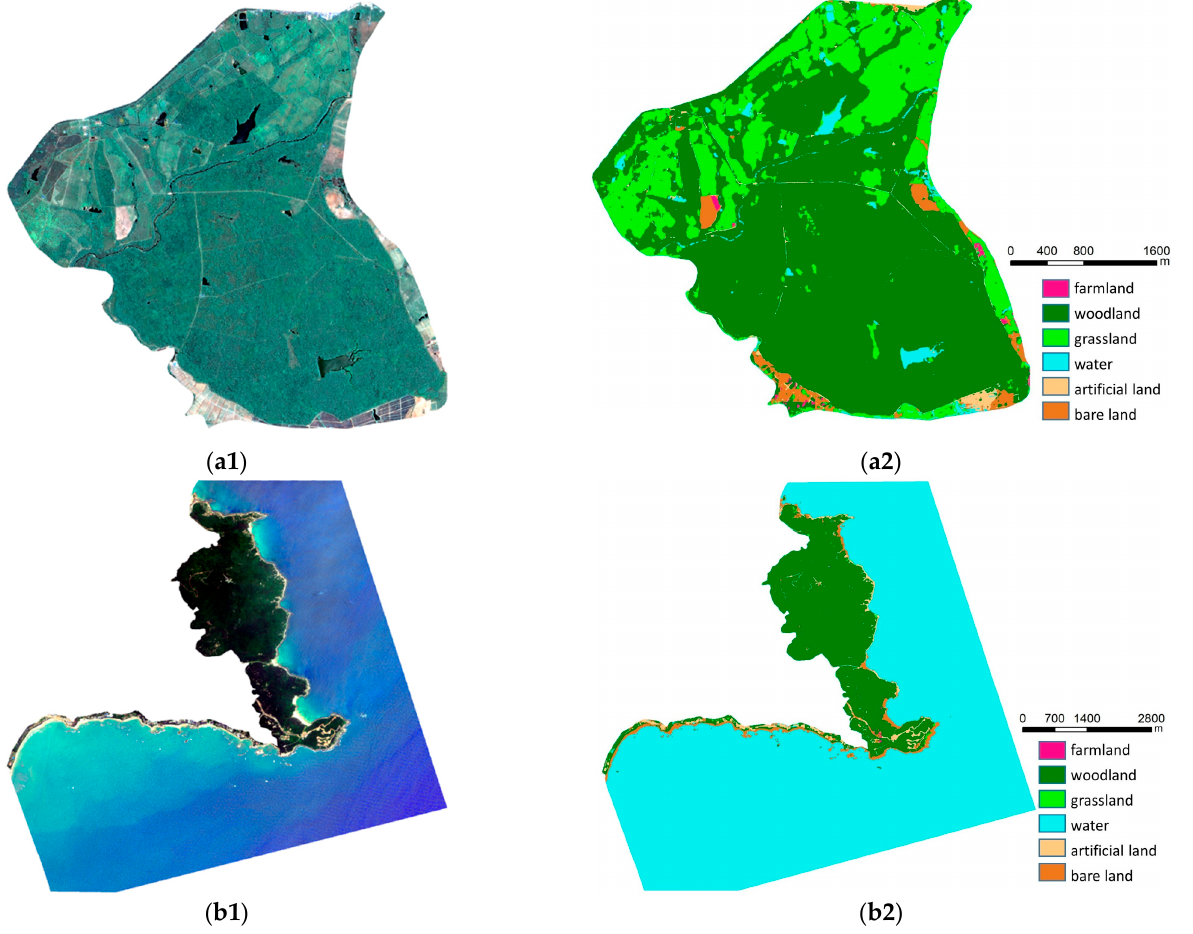
Figure 15. Classification results for nature reserves based on multi-spectral images. ( a1 ) Image of Datian Nature Reserve. ( a2 ) Label of Datian Nature Reserve. ( b1 ) Image of Tongguling Nature Reserve. ( b2 ) Label of Tongguling Nature Reserve.